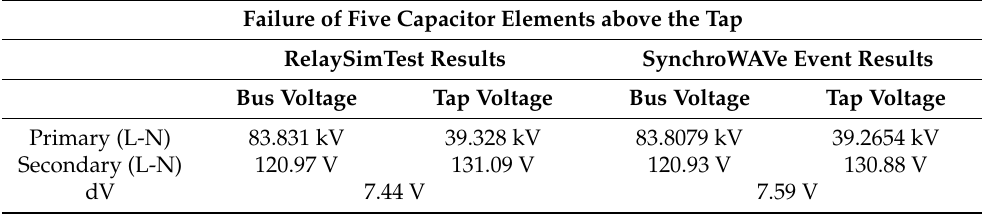
Table 4. A summary of simulation results for five-element failures below the tap.